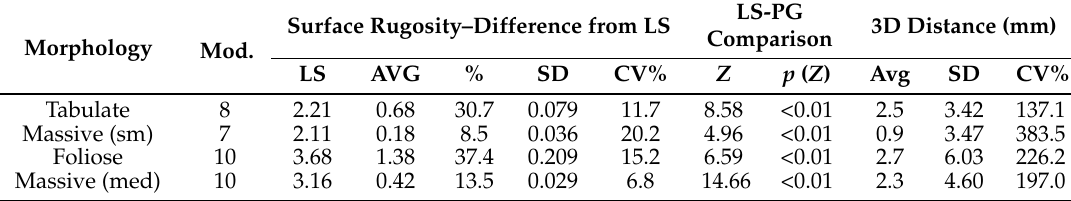
Table 3. Summary of small-scale accuracy assessment. The average (AVG), percent (%, relative to LS), SD and CV (%) of the difference in surface rugosity between the laser scan (LS) and each photogrammetry (PG) model as well as results of the normal deviate test ( Z -test) are given for each morphology. The average, SD and CV (%) of the distance between the LS 3D model and the average of all PG models is also given.